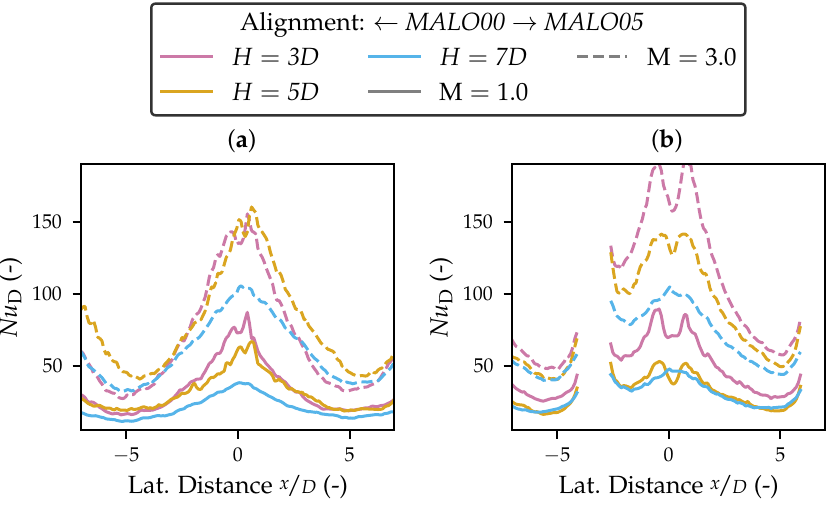
Figure 8. Nusselt number on the impingement side of the effusion specimen at the jet location. Different cavity heights and blowing ratios shown for ( a ) aligned case MALO00 and ( b ) misaligned case MALO05